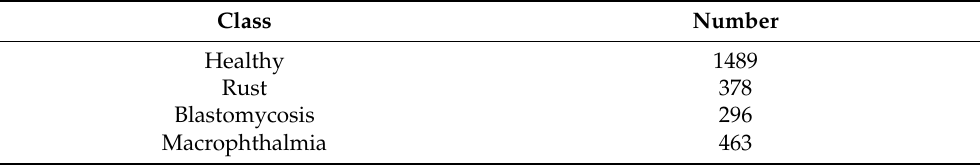
Table 4. Distribution of the wheat dataset in this paper.